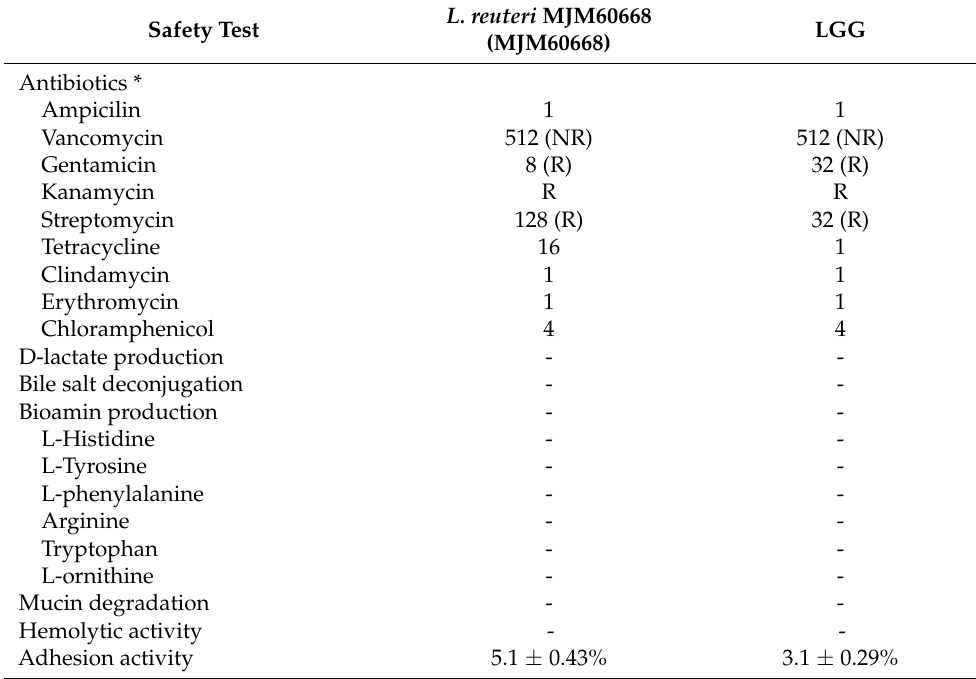
Table 2. Safety assessment of L. reuteri